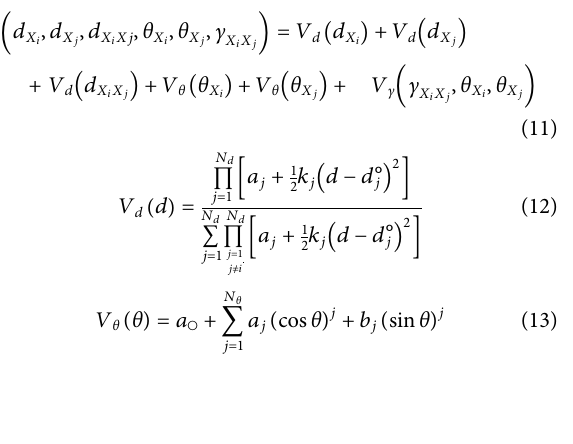
T = 298 K, hence RT = 0.591 kcal/mol, and A (default 15) is the